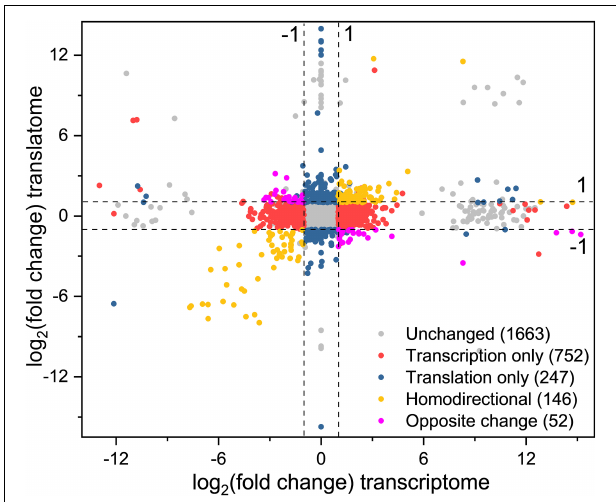
FIGURE 4 | Simultaneous monitoring of the changes at the transcription and translation levels in L. rhamnosus ATCC 53103 under osmotic stress. Plot of the log 2 fold change of RPFs (OS/CG) against the log 2 fold change of respective mRNAs (OS/CG). The four dash lines indicate log 2 fold change values -1 or +